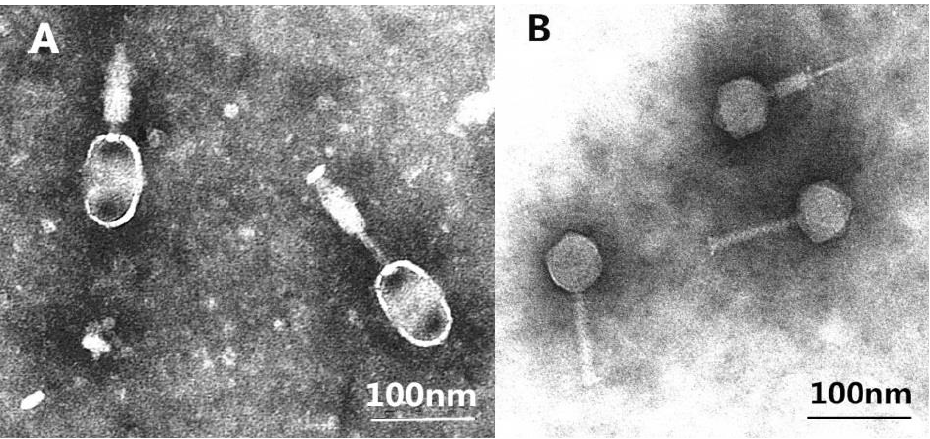
Figure 1. Transmission electron micrographs (TEM) of phage PA13076 ( A ) and PC2184 ( B ).